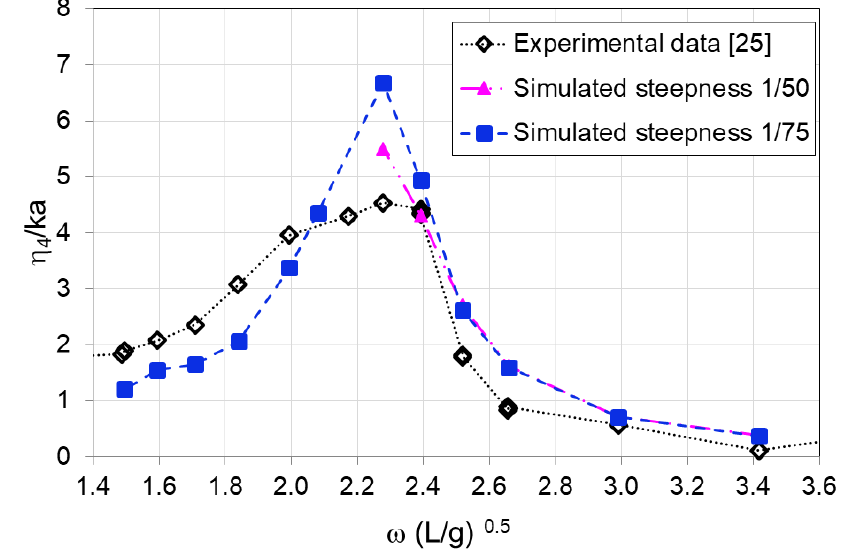
Figure 11. Roll RAO in beam wave: comparison between experimental and simulated results.